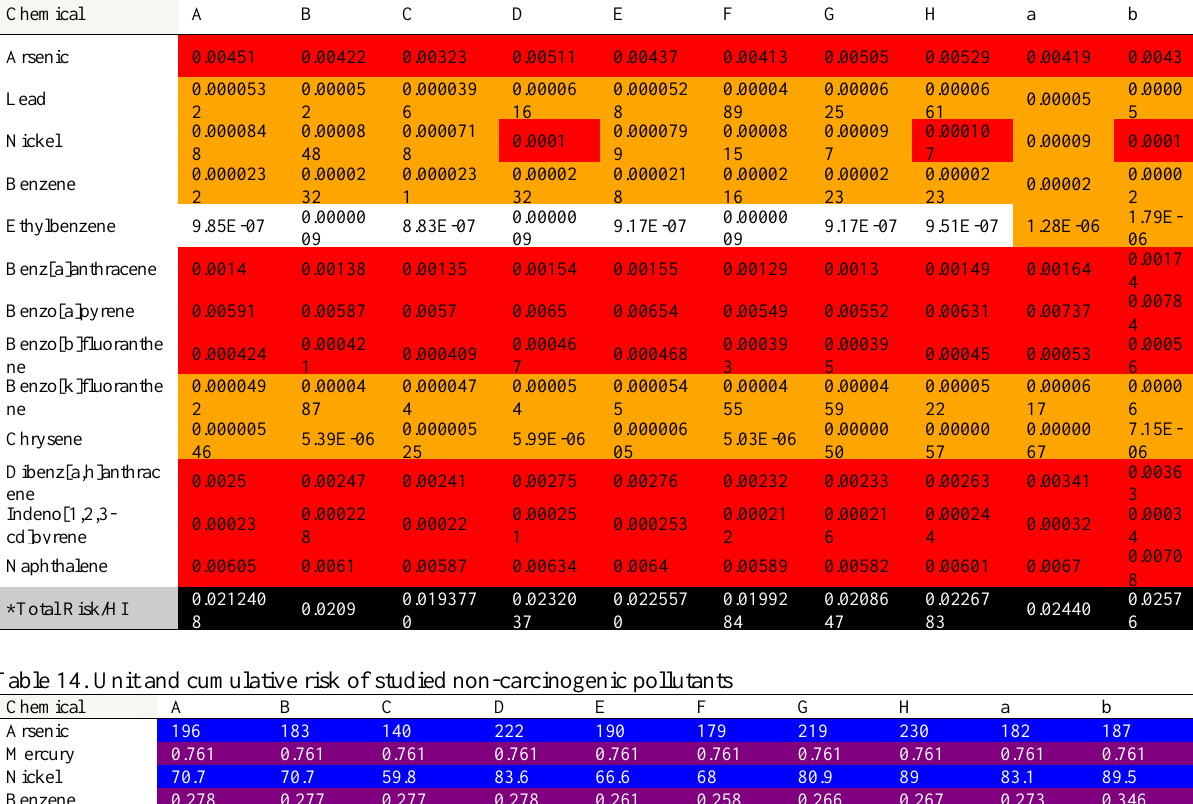
Table 13. Single and cumulative risk of studied carcinogenic pollutants Chemical